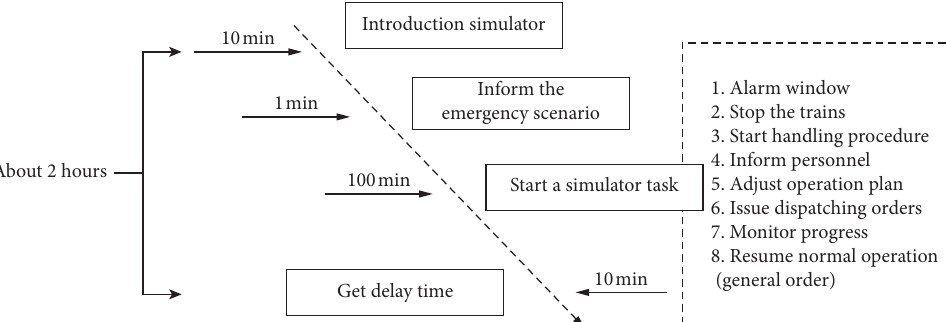
Figure 8: The procedure of the dispatch simulator task.